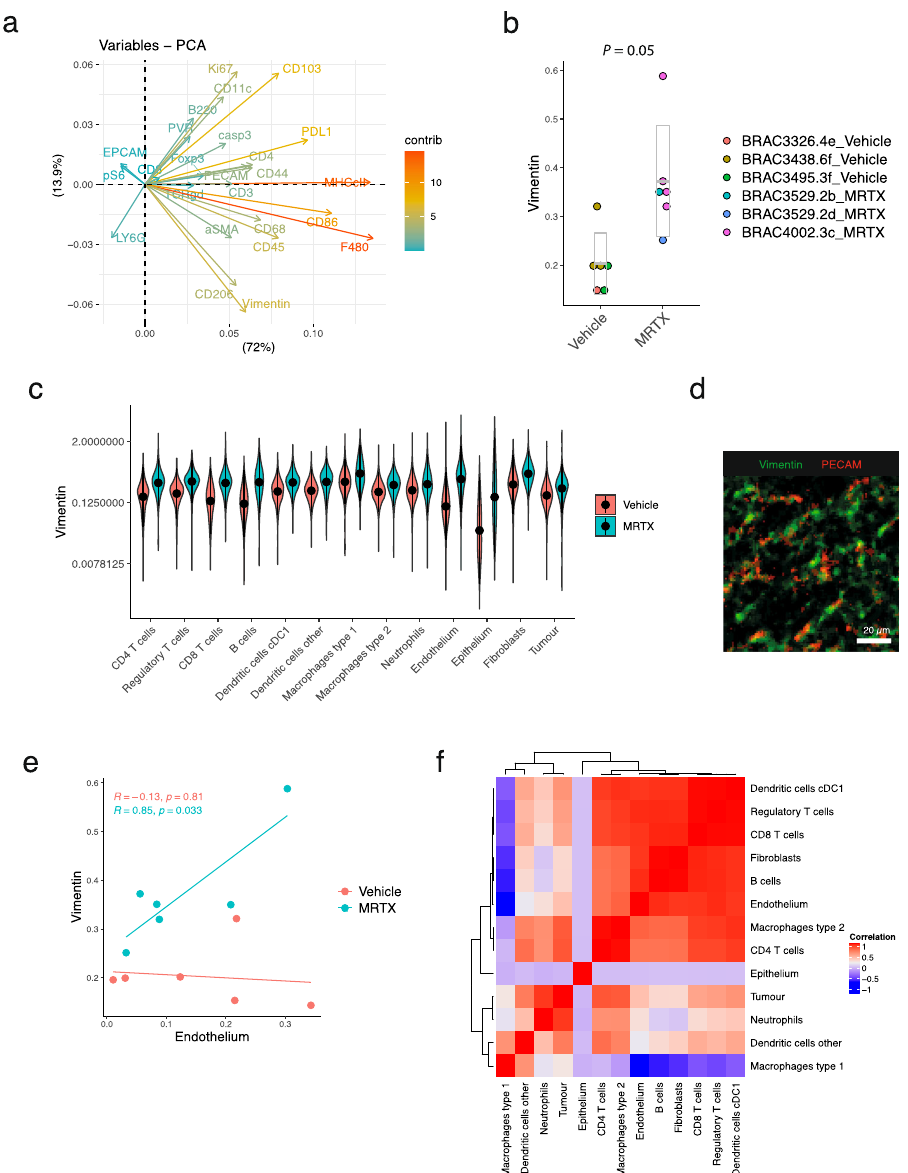
Fig. 6 MRTX1257 treatment is correlated with increased vimentin expression and tumour vascularisation. a Plot depicting the contribution of the mean intensity of markers per mouse that have contributed to the fi rst two principal components (PC1 and PC2 on and x and y axis, respectively) of the PCA analysis from Supplementary Fig. 4c. b Mean intensity of vimentin per ROI, separated by treatment group on the x -axis. Points are coloured by mouse ID as indicated in the legend. P value = 0.03, extracted from ANOVA testing of linear mixed-effects model. c Distribution of vimentin expression across cell types separated by treatment, means are indicated with a dot. ANOVA testing of a linear mixed-effects model found that the two treatment conditions had a signi fi cantly different vimentin expression pro fi le across the cell types ( P < 0.0001 for treatment:cell type), and that these differences were signi fi cant for Endothelium ( P- adj = 0.04) and Epithelium ( P -adj = 0.02, corrected for multiple testing by adjusting for false discovery rate (FDR)). d Crop of PECAM and vimentin expression in a tumour treated with MRTX1257. For visualisation purposes, the images were processed in Fiji with a median fi lter (radius 0.5). e Vimentin expression and proportion of endothelium cells in the tissue are positively correlated for the MRTX1257 treated ROIs, but not for the vehicle- treated ROIs (two-sided Pearson correlation testing, not adjusted for multiple testing). No other correlations between cell type and vimentin expression were found to be signi fi cant. f Pearson correlation matrix of cell type proportions in the tumour domain of MRTX1257 treated tumours, extracted from the linear mixed-effects model using the mouse:ROI estimates. MRTX